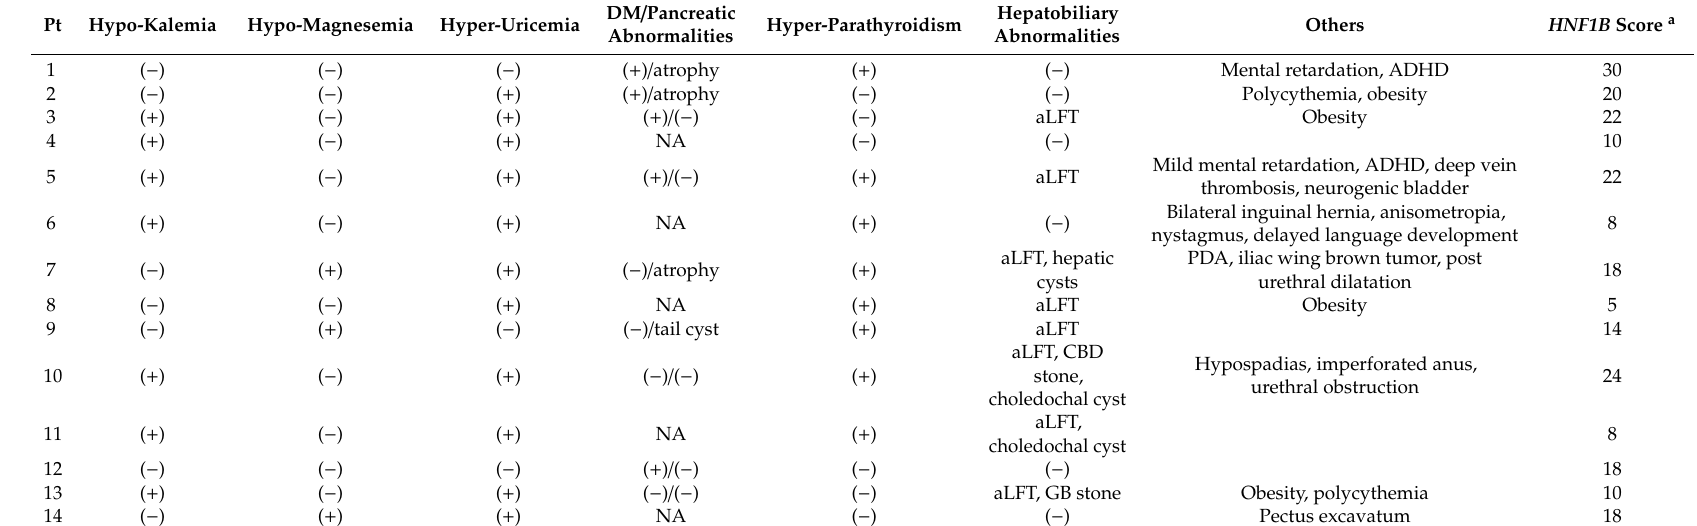
Table 2. Extrarenal phenotypes of the